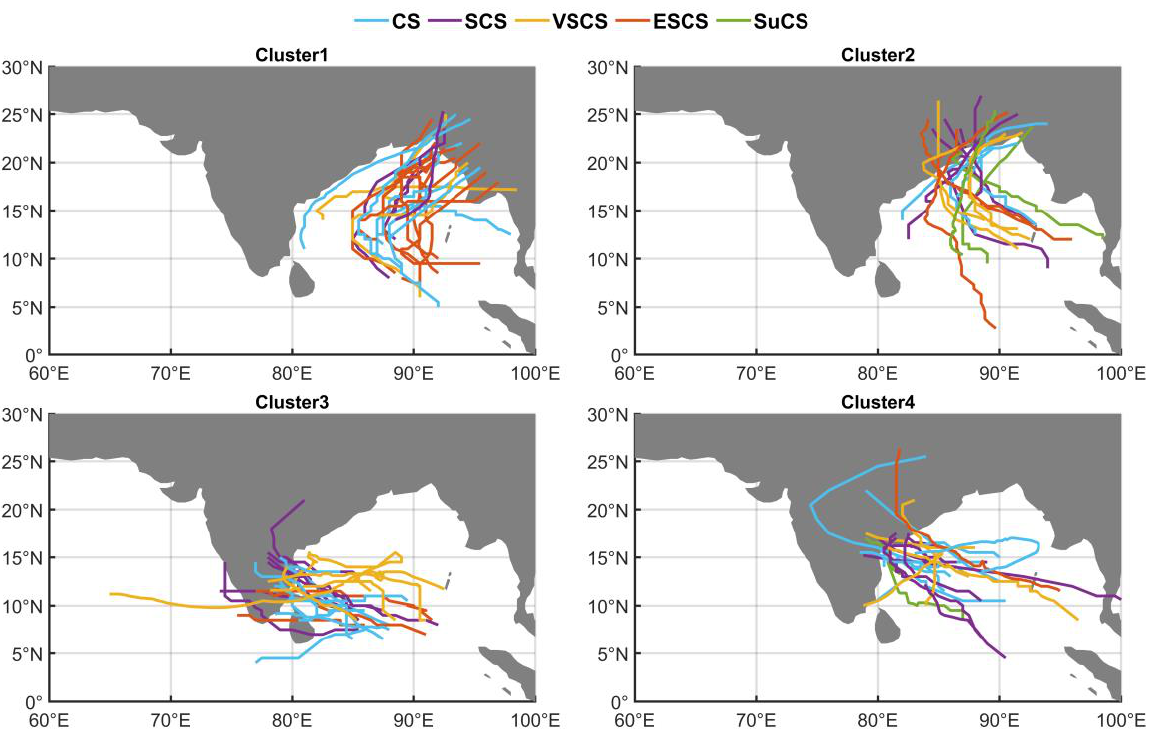
Figure 2. Tracks of TCs obtained in each cluster. Cluster-1 consists of tracks moving north – eastward, Cluster-2 having the tracks moving northward, Cluster-3 consists of tracks moving westward, and Cluster-4 consists of tracks moving in the west – northwestward directions. TC tracks are shown based on IMD intensity classification with different colours.